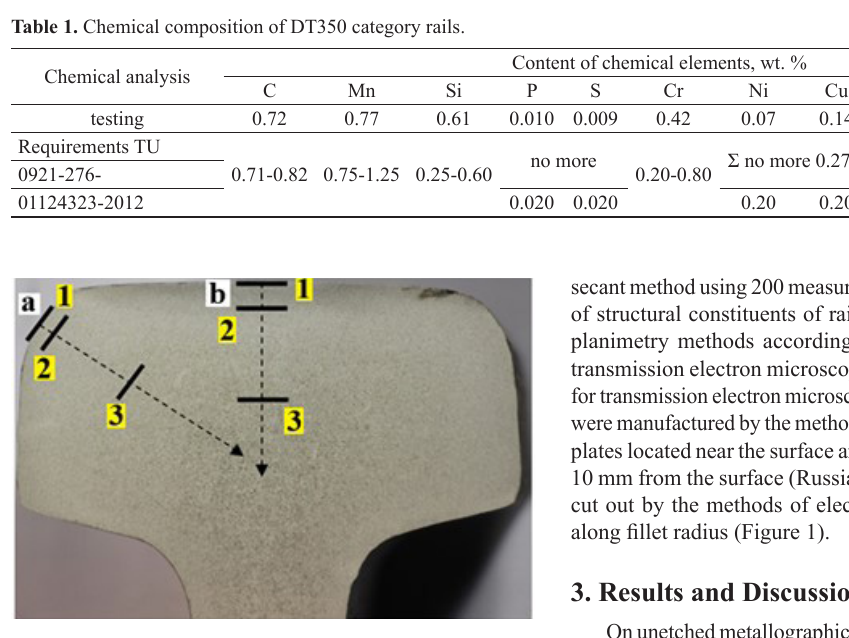
Figure 1. Diagram of sample preparation by methods of transmission electron microscopy. 1-tread surface, 2-layer at 2 mm from surface, 3-layer at 10 mm from surface; a) fillet; b) central